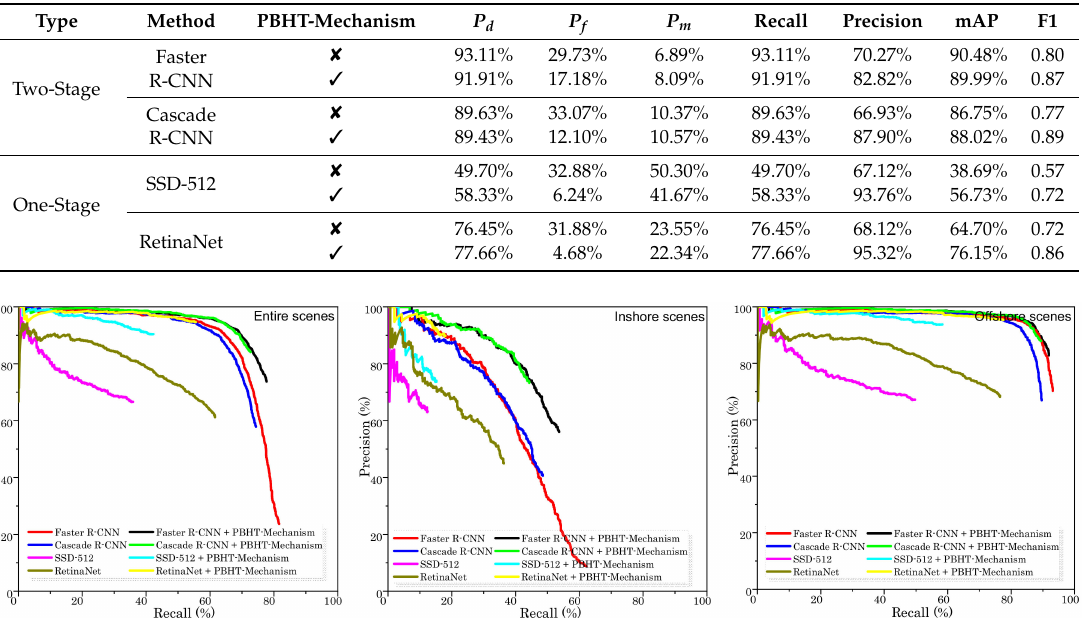
Table 15. Detection performance with and without PBHT-mechanism on the o ff shore scenes.